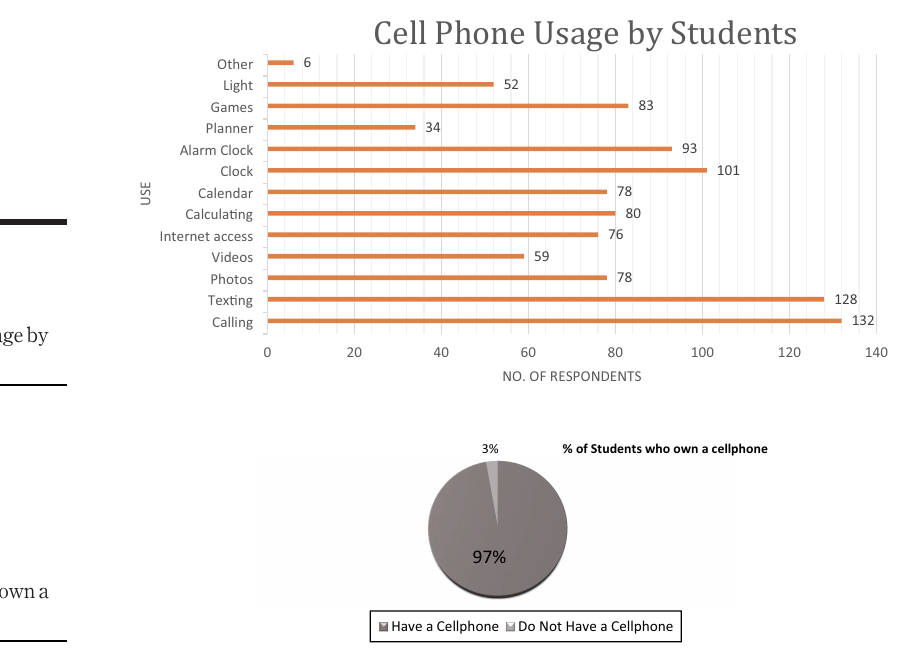
Figure 5. Percentage of students who own a